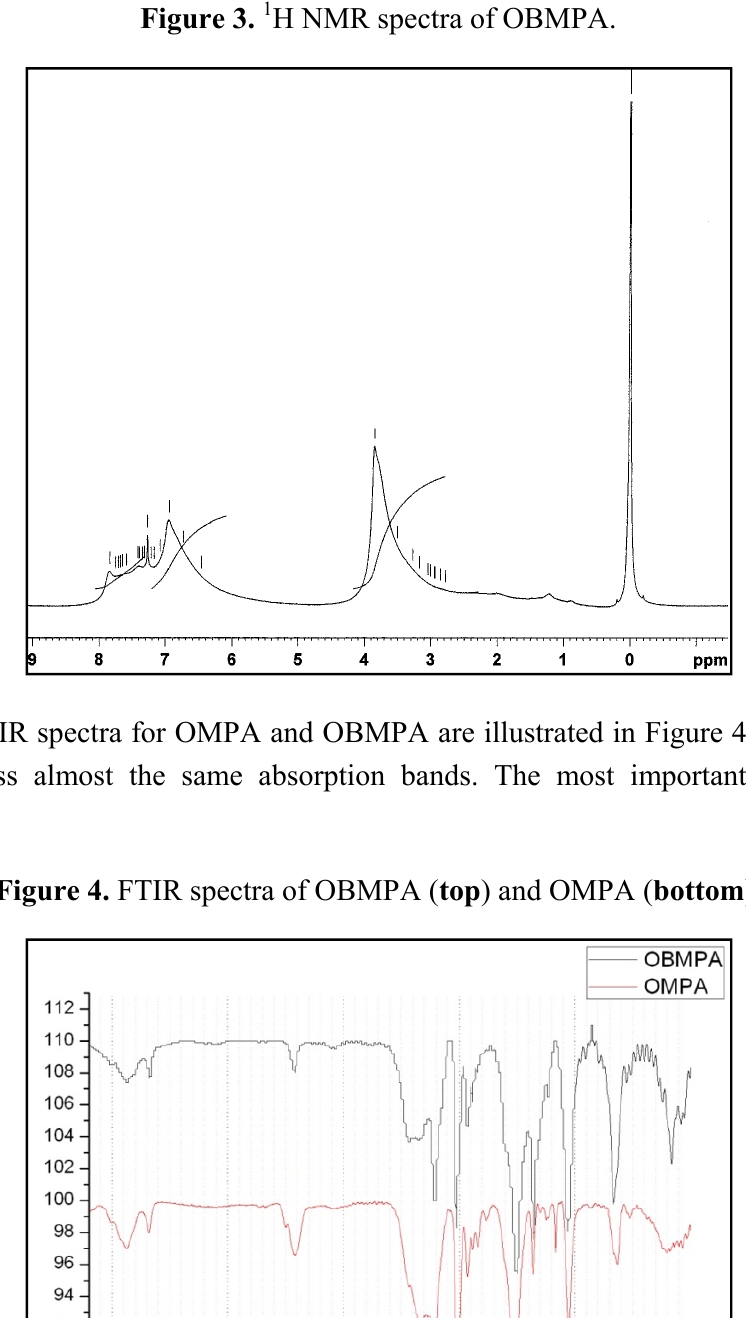
Figure 3. 1 H NMR spectra of OBMPA.